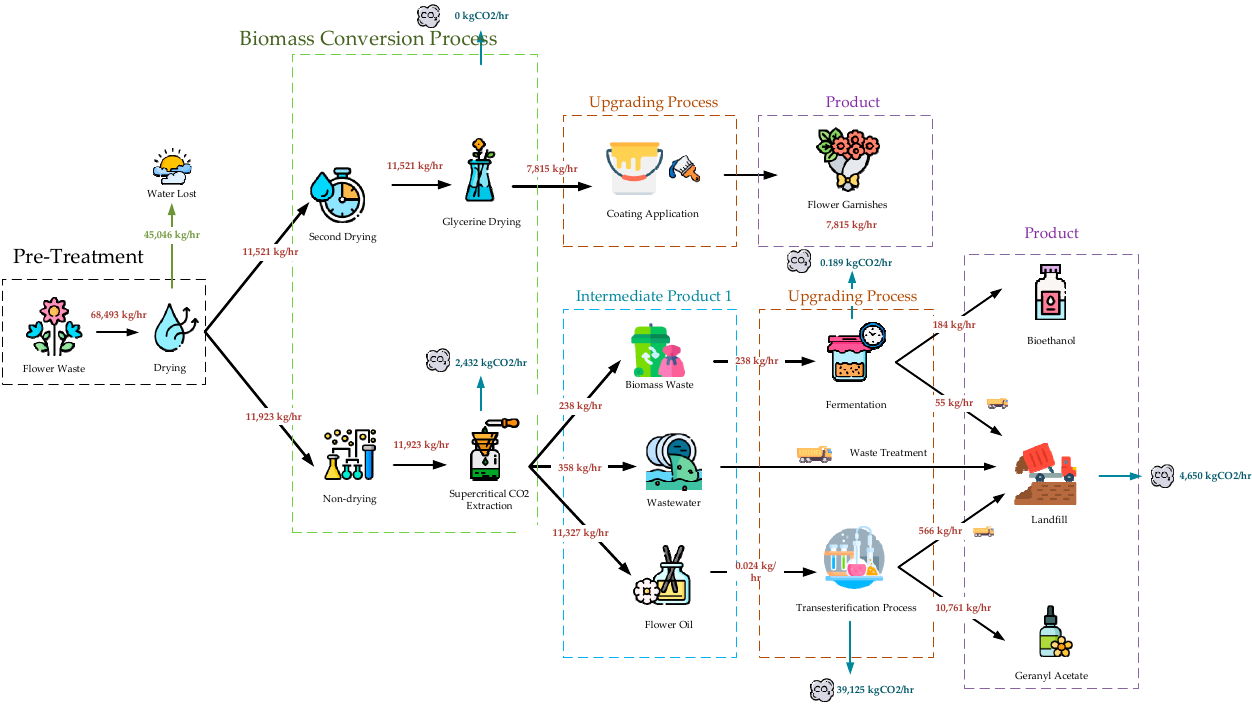
Figure 5. Optimisation based on maximum economic potential and minimum environmental im- pact—scenario 3. scenario